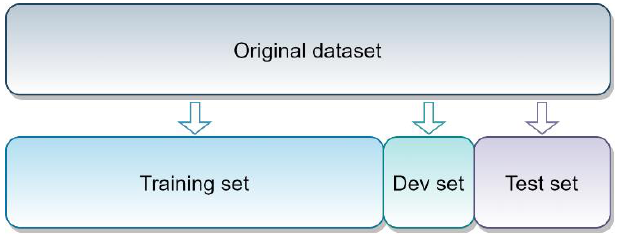
Figure 3. Hold-out validation method.